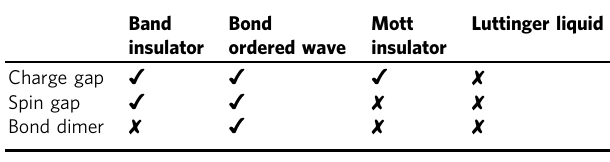
Table 1 Theoretical characterization of the different phases of matter that can be realized in twisted GeSe 34 – 38